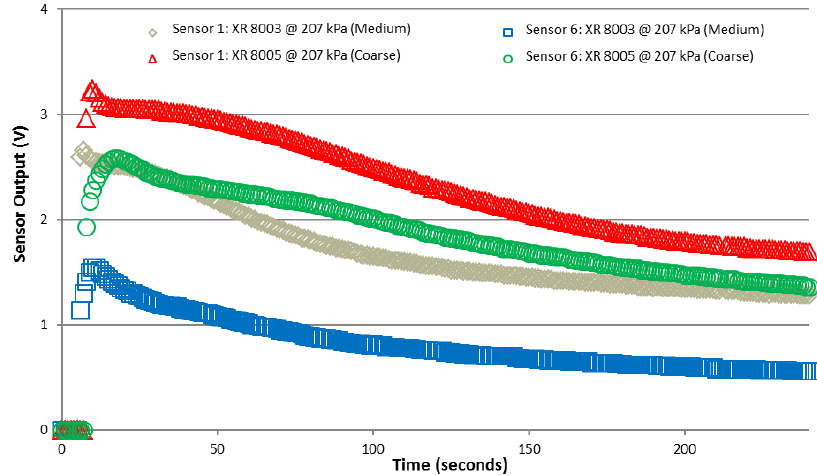
Figure 5. Sensors 1 and 6 voltage output from XR 8003 and XR 8005 nozzles at 207 kPa operated at constant speed in spray chamber.